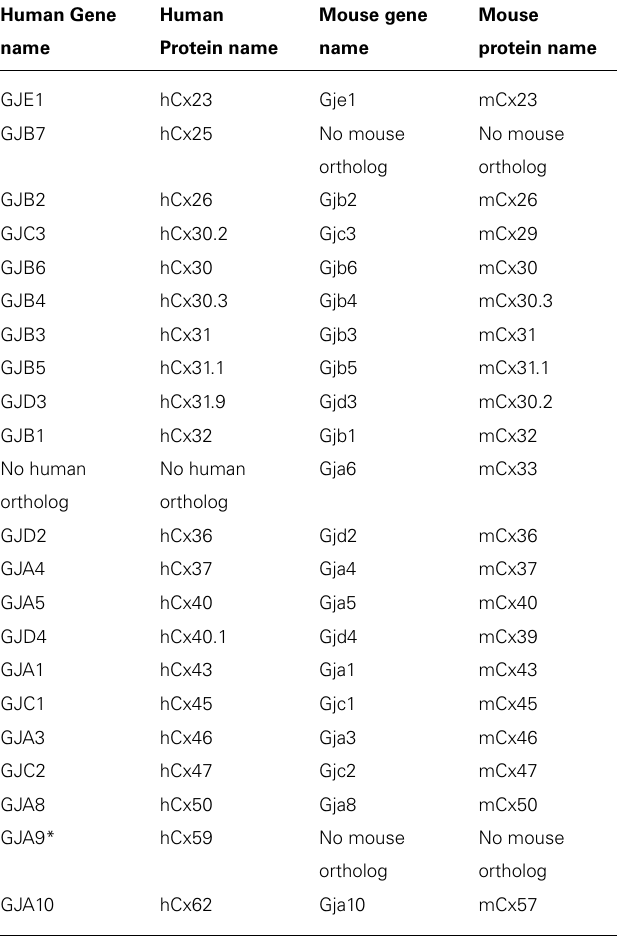
Table 1 | Nomenclature of human and mouse connexin genes and proteins.